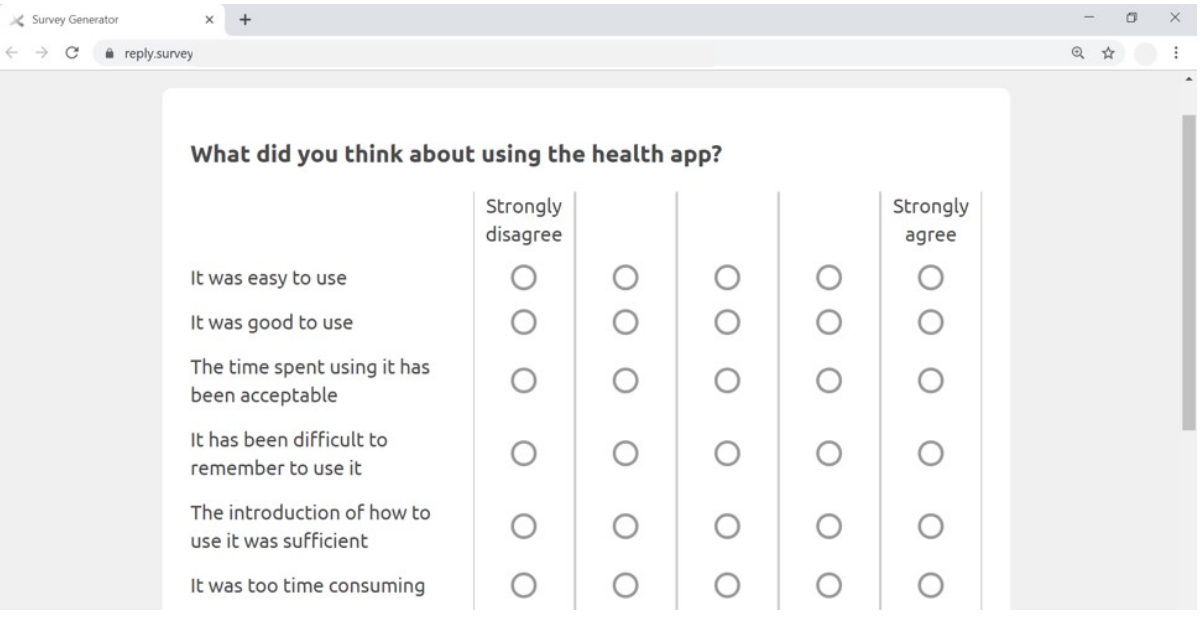
Figure 1. Screenshot of the Web-based mHealth Satisfaction